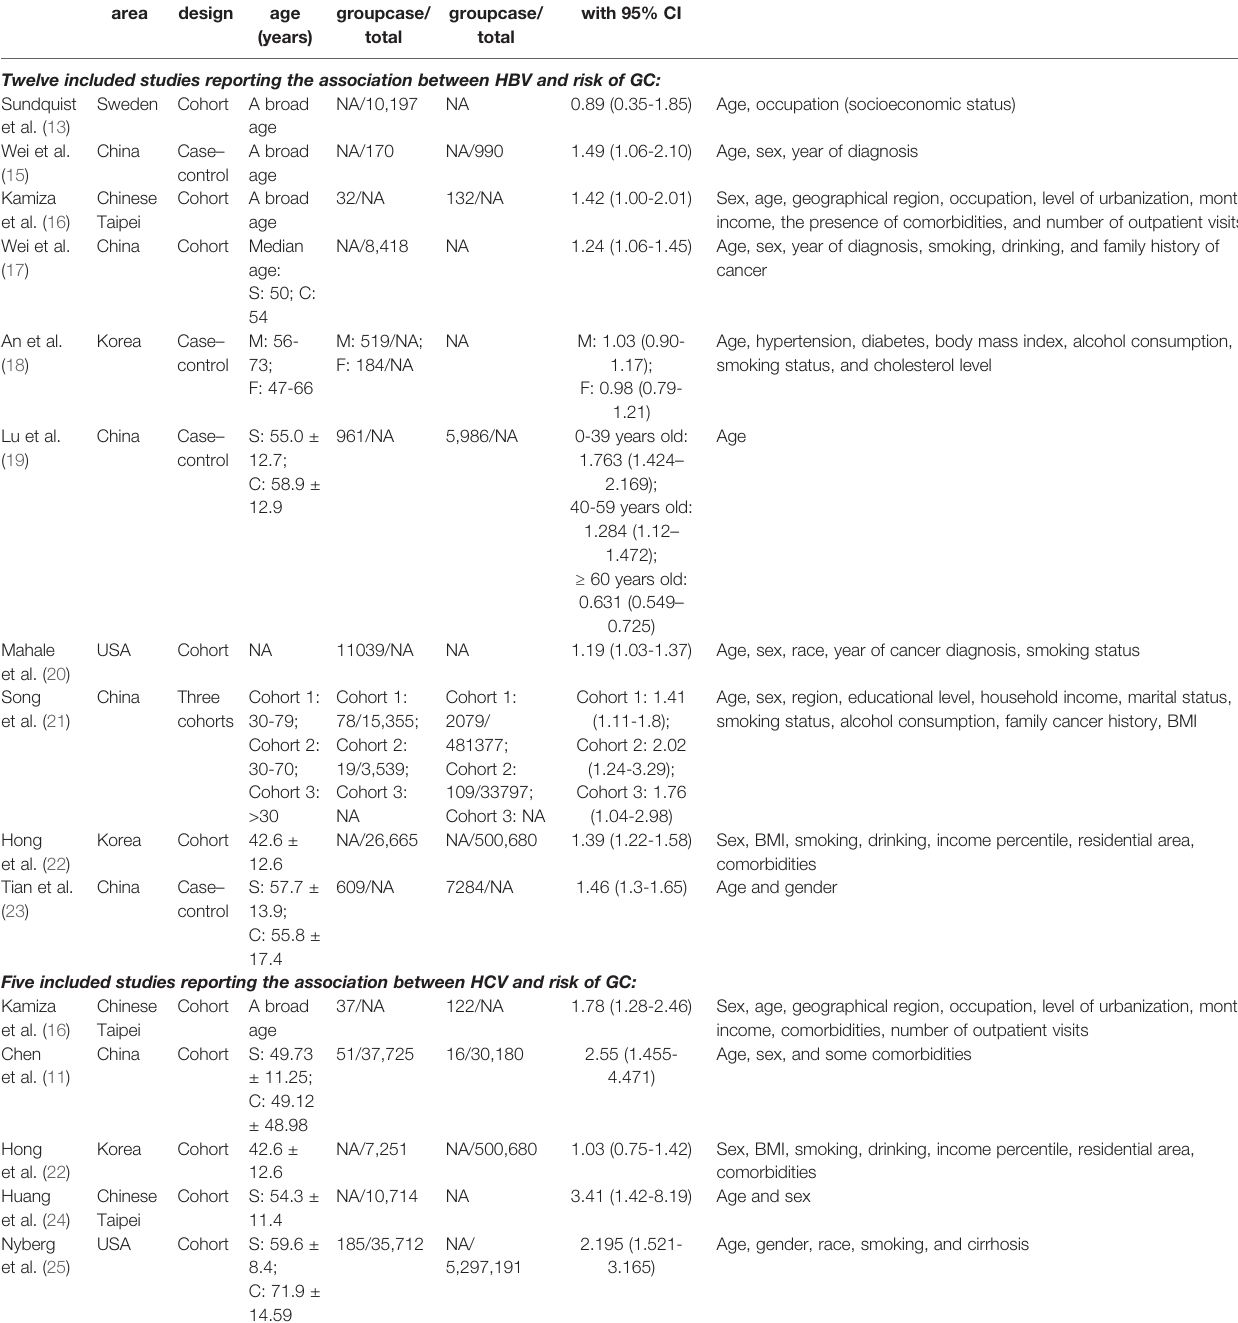
TABLE 1 | Characteristics of the included